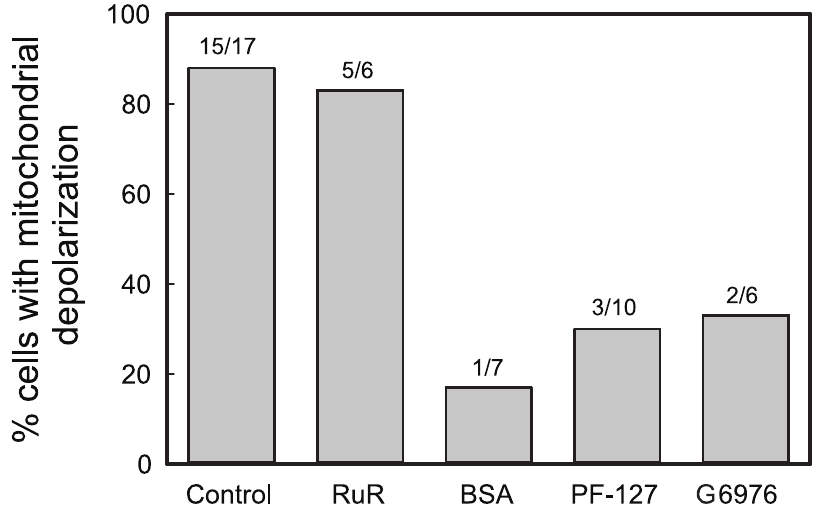
Figure 6. Summary of pharmacological interventions. Percentage of HUVECs exhibiting loss of DY m following air bubble contact under control conditions or following pre-treatment with 1 m mol/L ruthenium red (RuR), 5% BSA, 0.1% Pluronic F-127 (PF-127), or 5 m mol/L Go¨6976